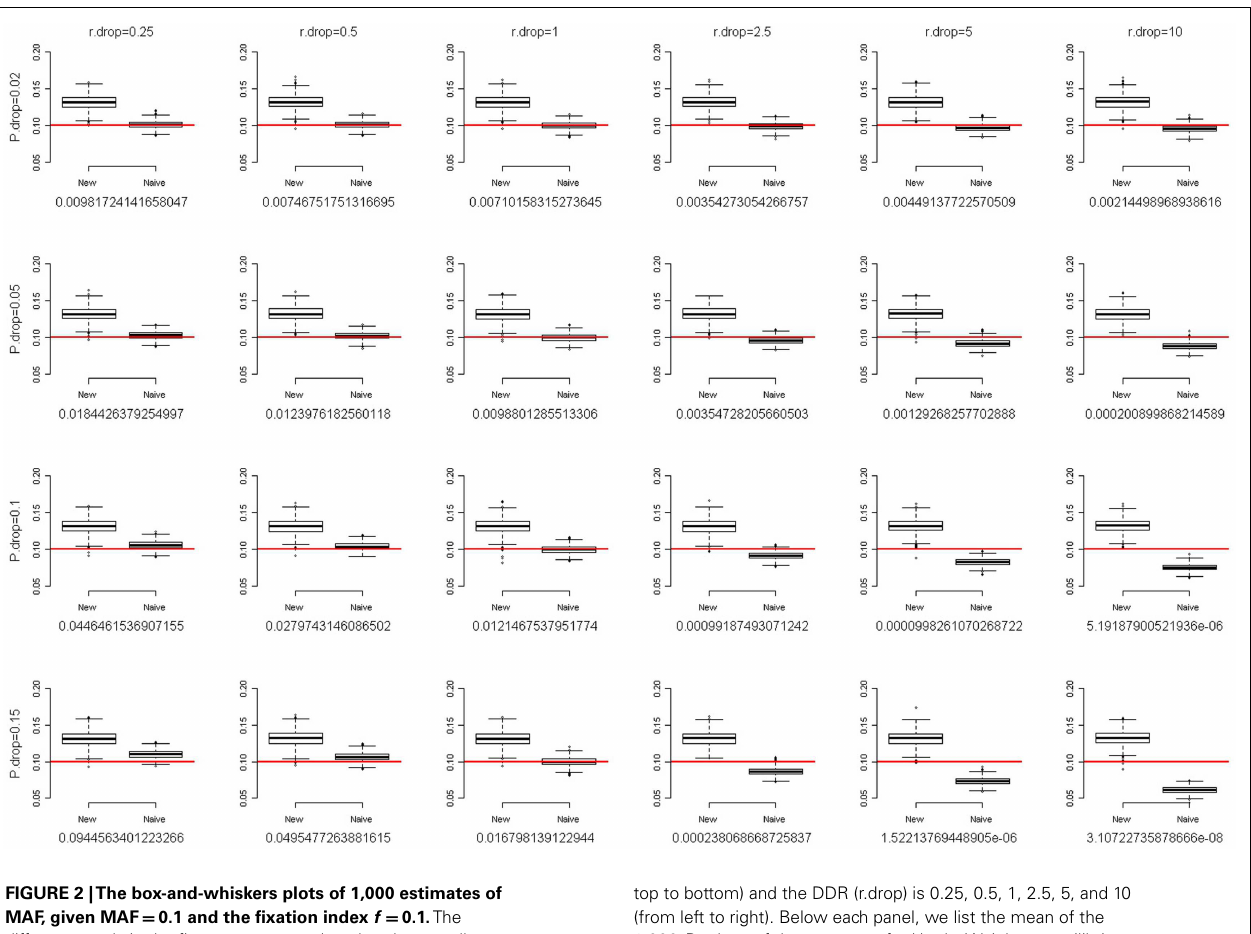
FIGURE 2 |The box-and-whiskers plots of 1,000 estimates of MAF, given MAF = 0.1 and the fixation index f = 0.1. The different panels in the figure are arranged so that the overall genotype missing rate (P.drop) is 0.02, 0.05, 0.1, and 0.15 (from